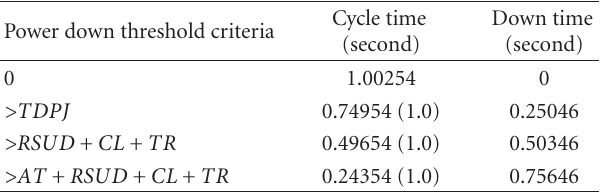
Table 15: Power Down Threshold cases for an open system and their associated down